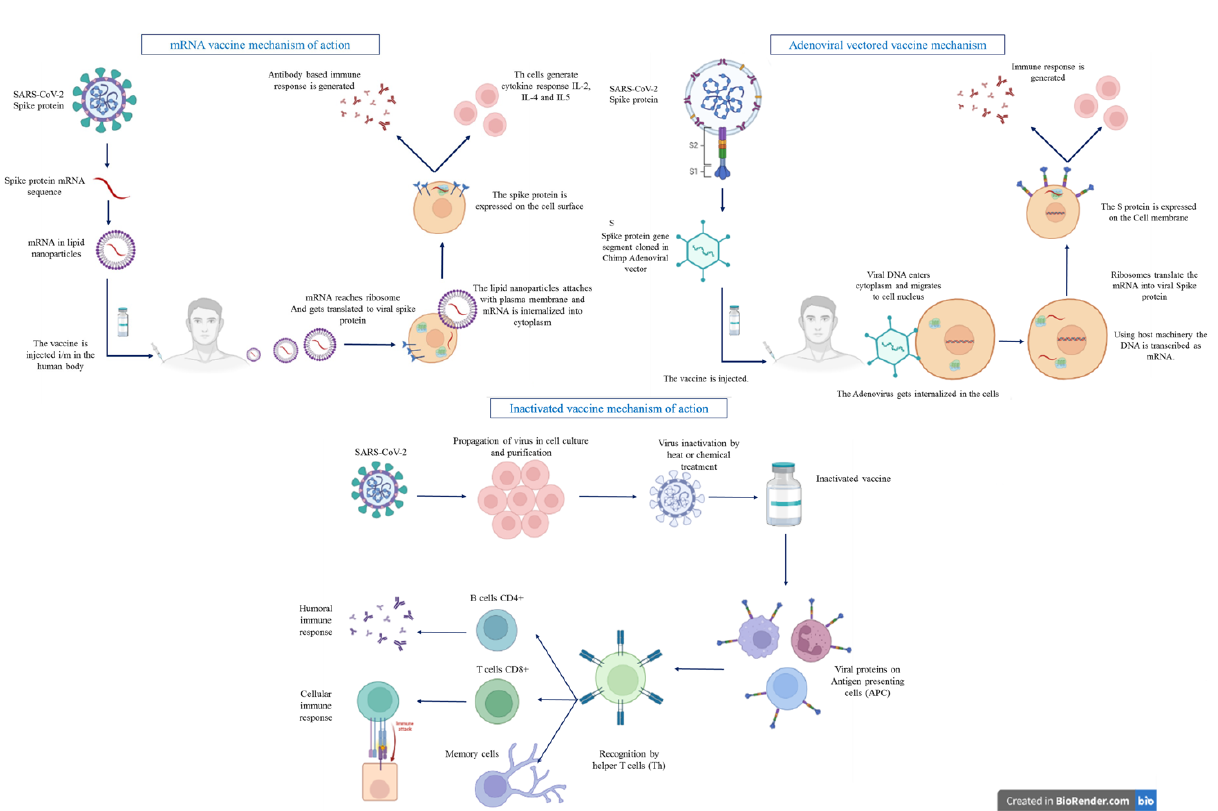
Figure 1. The mechanism of action by which immune response is generated by mRNA vaccine, ad- enoviral vaccines, and inactivated vaccines. Figure created using Biorender (https://biorender.com/ Accessed on 6 th April 2022.